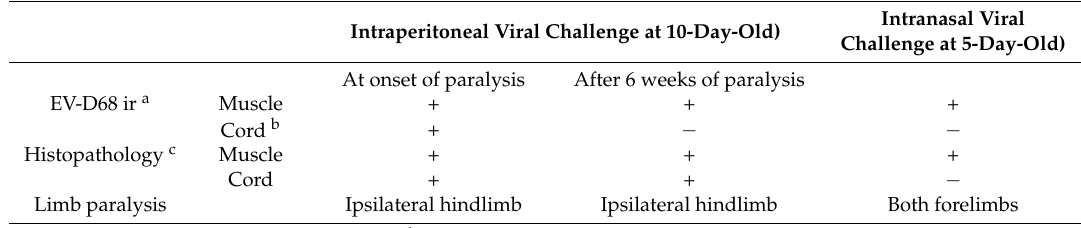
Table 2. Comparison of intranasal vs. intraperitoneal EV-D68 challenges. Intraperitoneal Viral Challenge at 10-Day-Old)